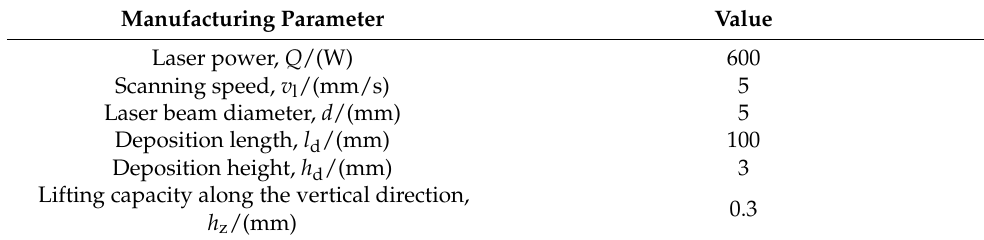
Table 2. Manufacturing parameters used in the experiment.